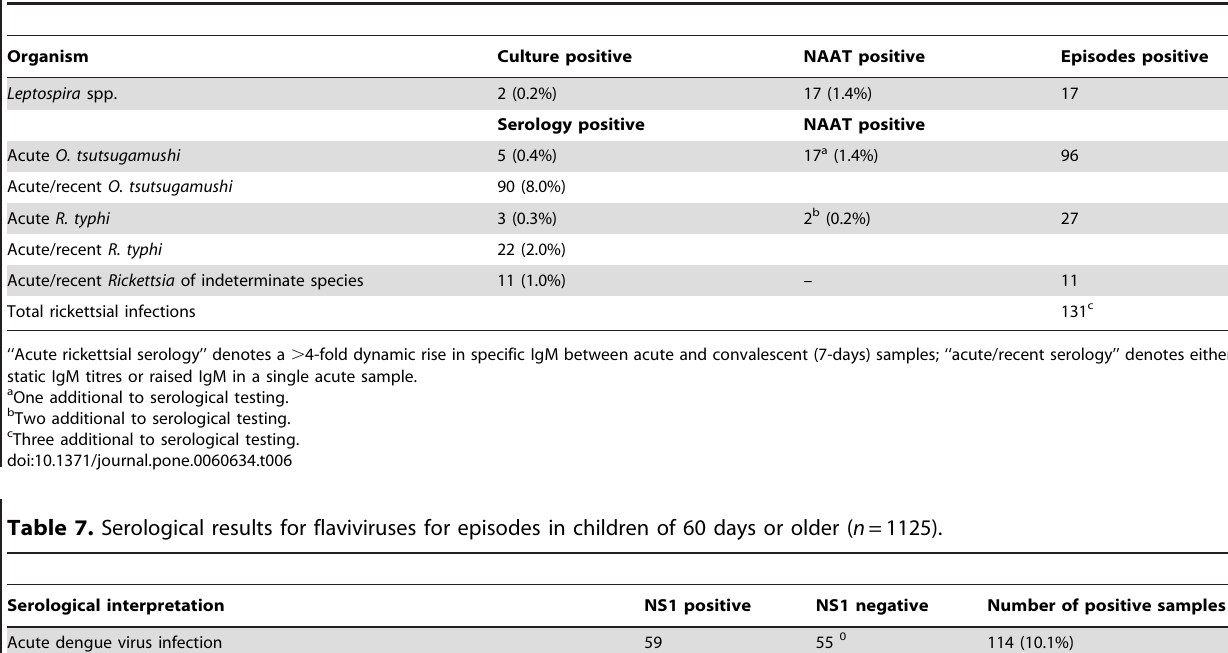
Serological interpretation